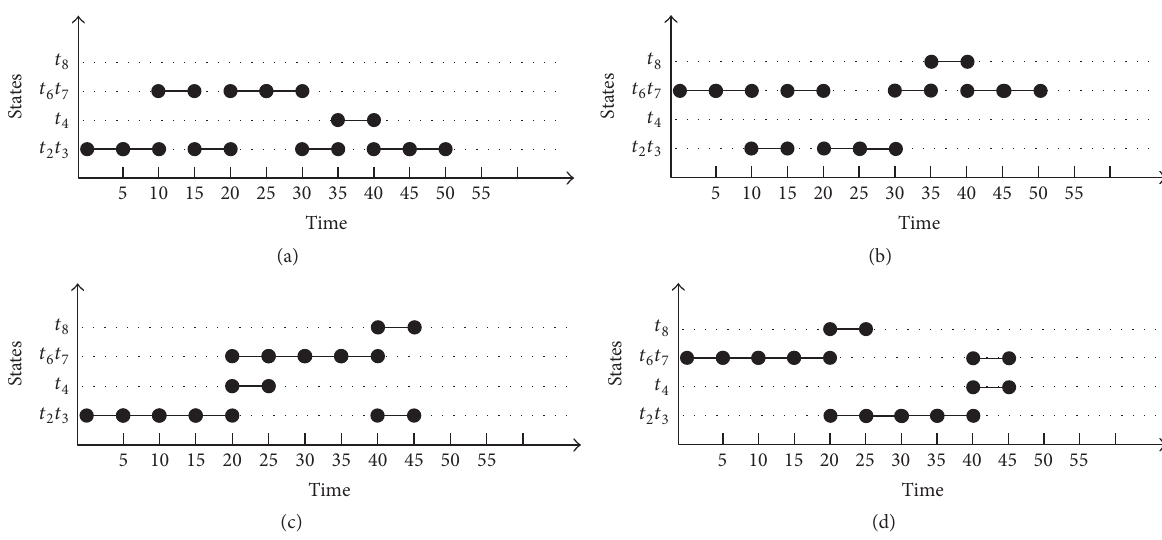
Figure 7: The firing sequences of (a) six T-Process 𝑡 2 𝑡 3 and three T-Process 𝑡 6 𝑡 7 , (b) three T-Process 𝑡 2 𝑡 3 and six T-Process 𝑡 6 𝑡 7 , (c) five T-Process 𝑡 2 𝑡 3 and four T-Process 𝑡 6 𝑡 7 , and (d) four T-Process 𝑡 2 𝑡 3 and five T-Process 𝑡 6 𝑡 7 .